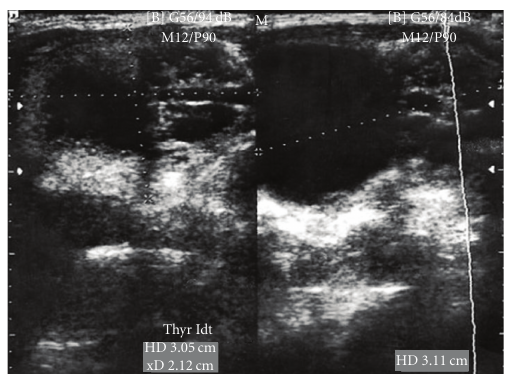
Figure 1: Thyroid ultrasonography showed a large lobulated cystic lesion in the right thyroid lobe and multiples adjacent little cysts in isthmus.